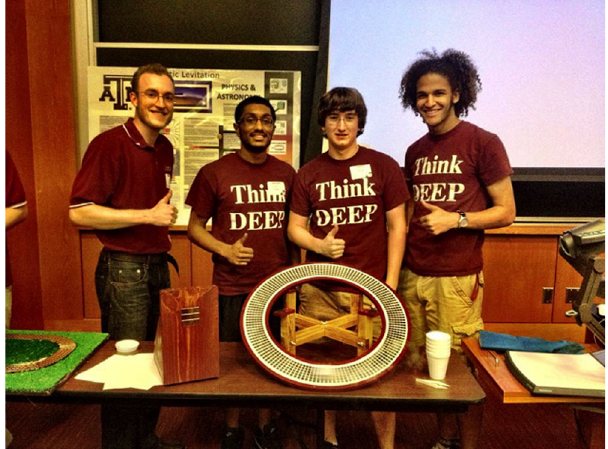
FIG. 2. DEEP team members with their superconducting train track. This demonstration experiment was part of Nobel Laureate David Lee ’ s public talk at the 2013 Physics & Engineering Festival. Photo by Natasha Sheffield.